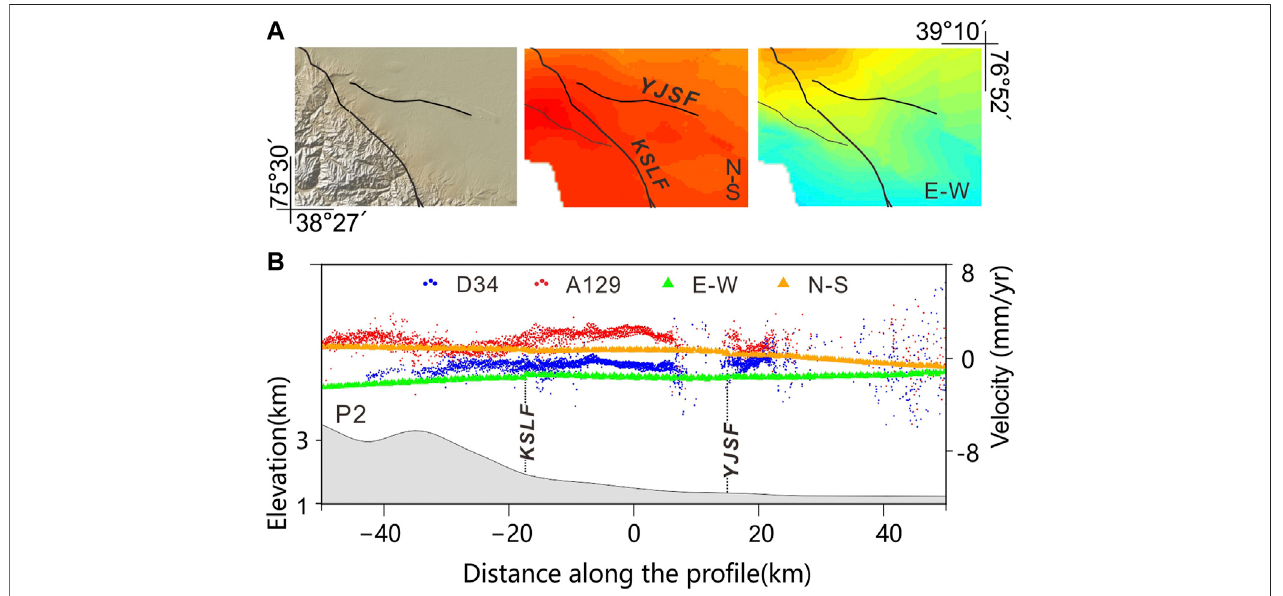
FIGURE 6 | (A) Enlargements of shaded elevation, the N-S and E-W velocity maps overing the western Kunlun piedmont thrust belt, the color bar is the same as Figure 3 . (B) Deformation data pro fi le across the western Kunlun piedmont thrust belt. See Figures 2 , 3 for P2 location. KSLF:kusilafu fault, YJSF:Yingjisha fault.